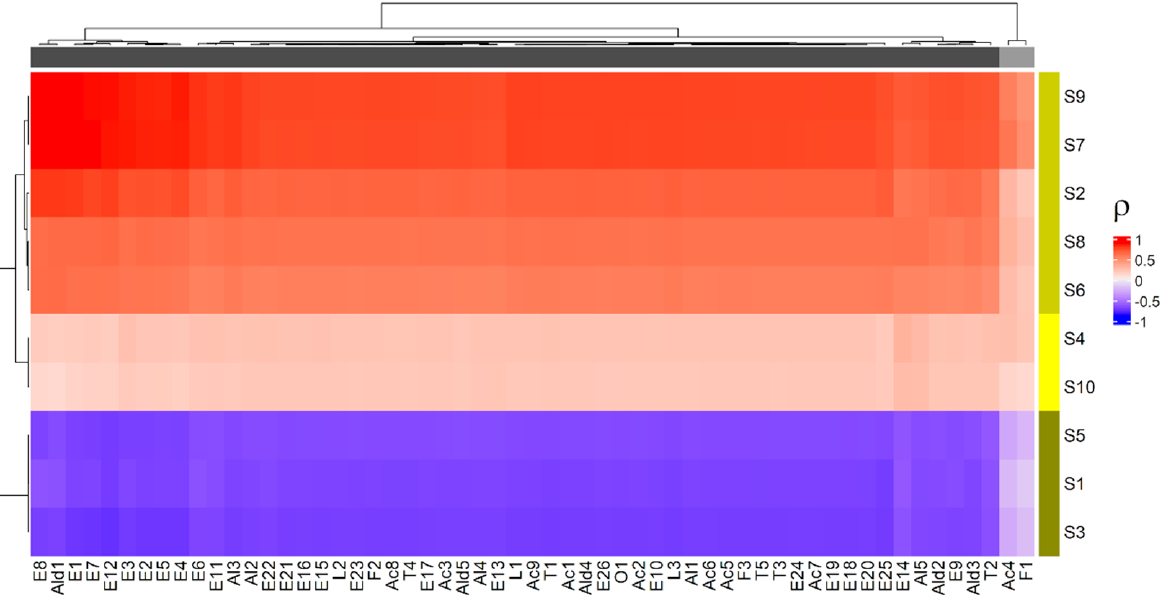
Figure 2. Heatmap: a different colour code was used to represent the clusters discovered by cluster analysis; ρ is the Pearson correlation coefficient.